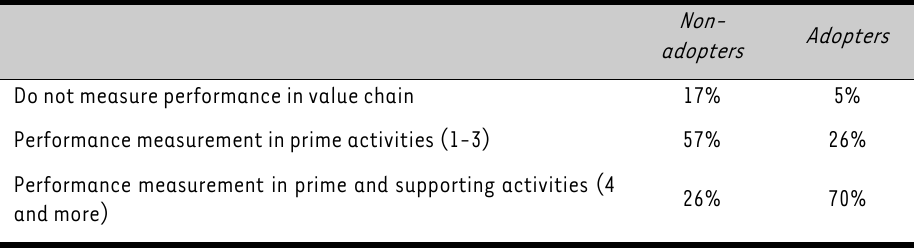
Non- Adopters adopters 26% 70%